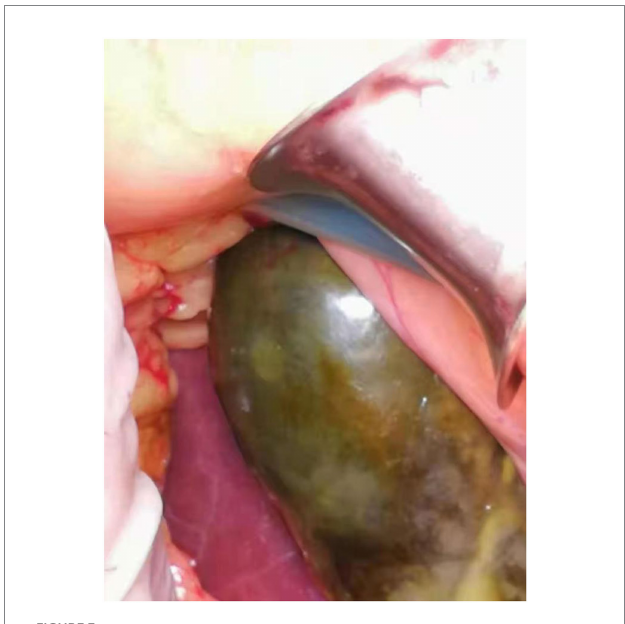
FIGURE 3 Gangrenous gallbladder visible on